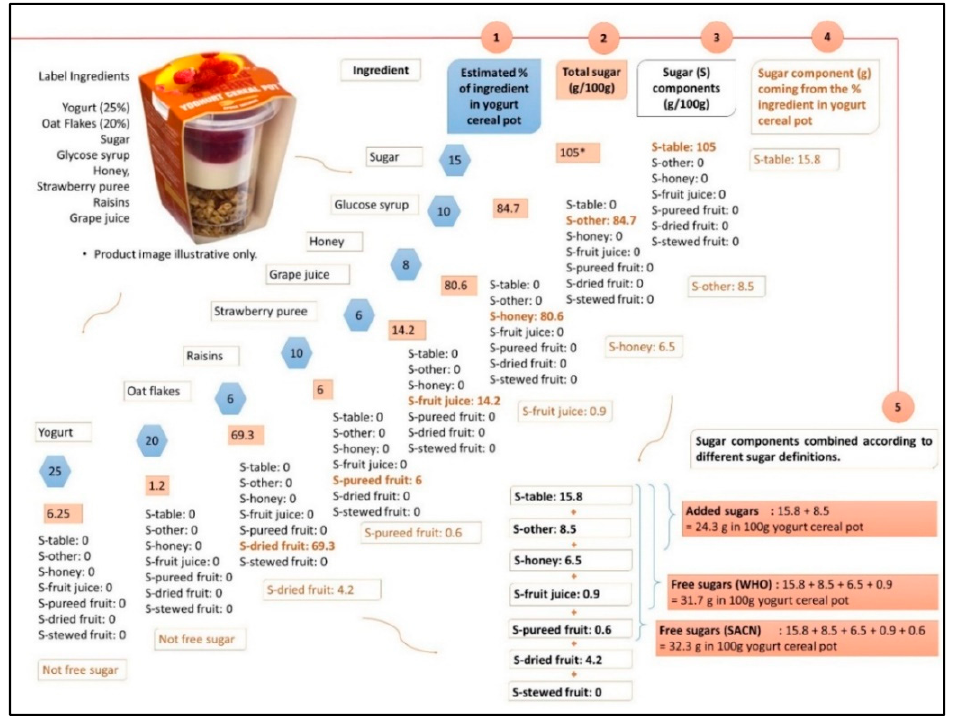
Figure 1. Steps for the estimation of free sugars and added sugars. * Sugar values expressed as monosaccharide equivalents which can exceed 100 g per 100 g of food because on hydrolysis 100 g of a disaccharide such as sucrose gives 105 g monosaccharide (glucose and fructose) [25]. S-table: sugar-table, S-other: sugar-other, S-honey: sugar-honey, S-fruit juice: sugar-fruit juice, S-fruit puree: sugar-fruit puree, S-stewed fruit: sugar-stewed fruit and S-dried fruit: sugar-dried fruit. WHO: World Health Organization. SACN: Scientific Advisory Committee on Nutrition.